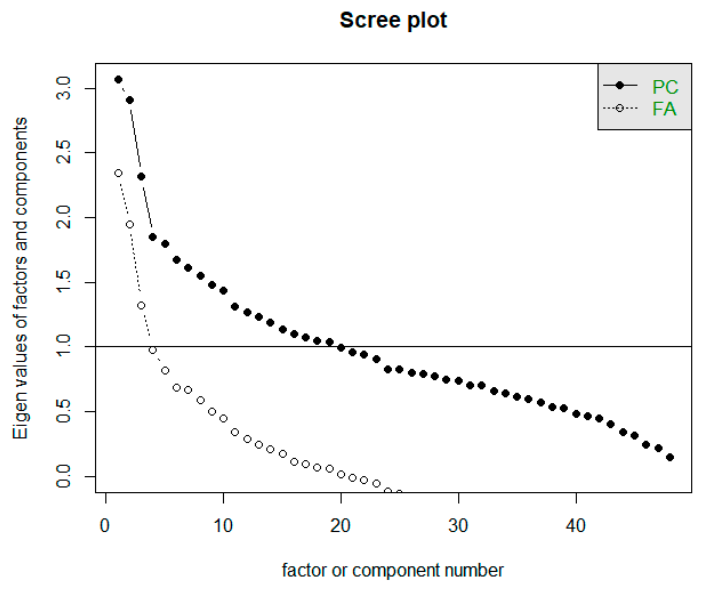
Figure 6. Representation of Scree plot to determine the number of factors.